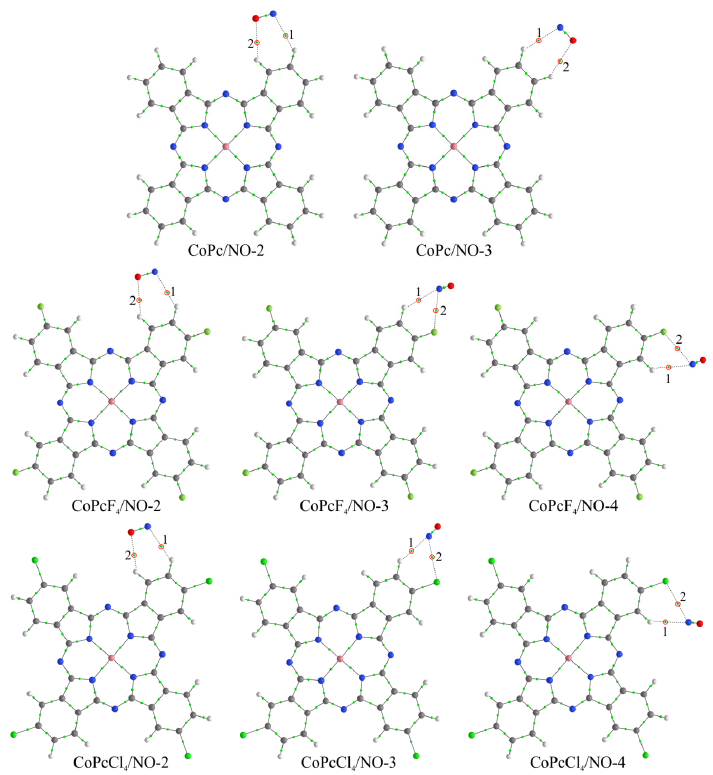
Figure 14. Structure of CoPcR 4 /NO- m aggregates, where R = H, F, and Cl, m = 2–4, and bond critical points in them. Red circles and numbers 1 and 2 indicate BCPs characterizing the NO molecule interaction with phthalocyanine atoms.